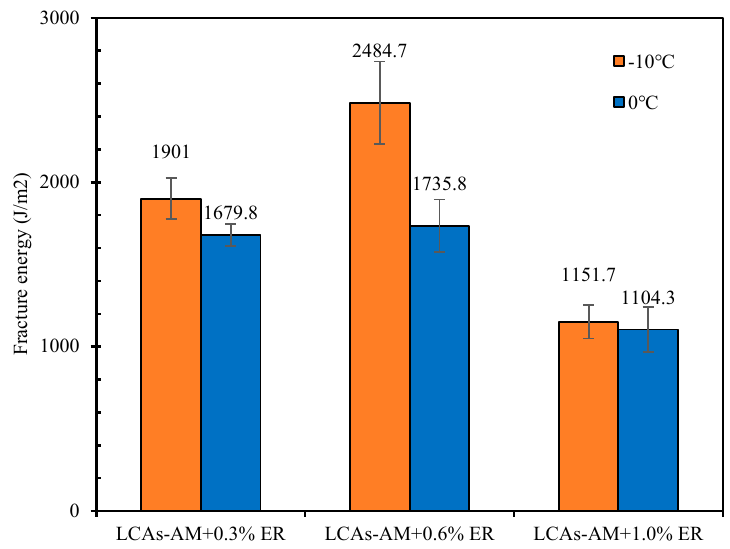
Figure 10. Low-temperature fracture energy with different ER contents.